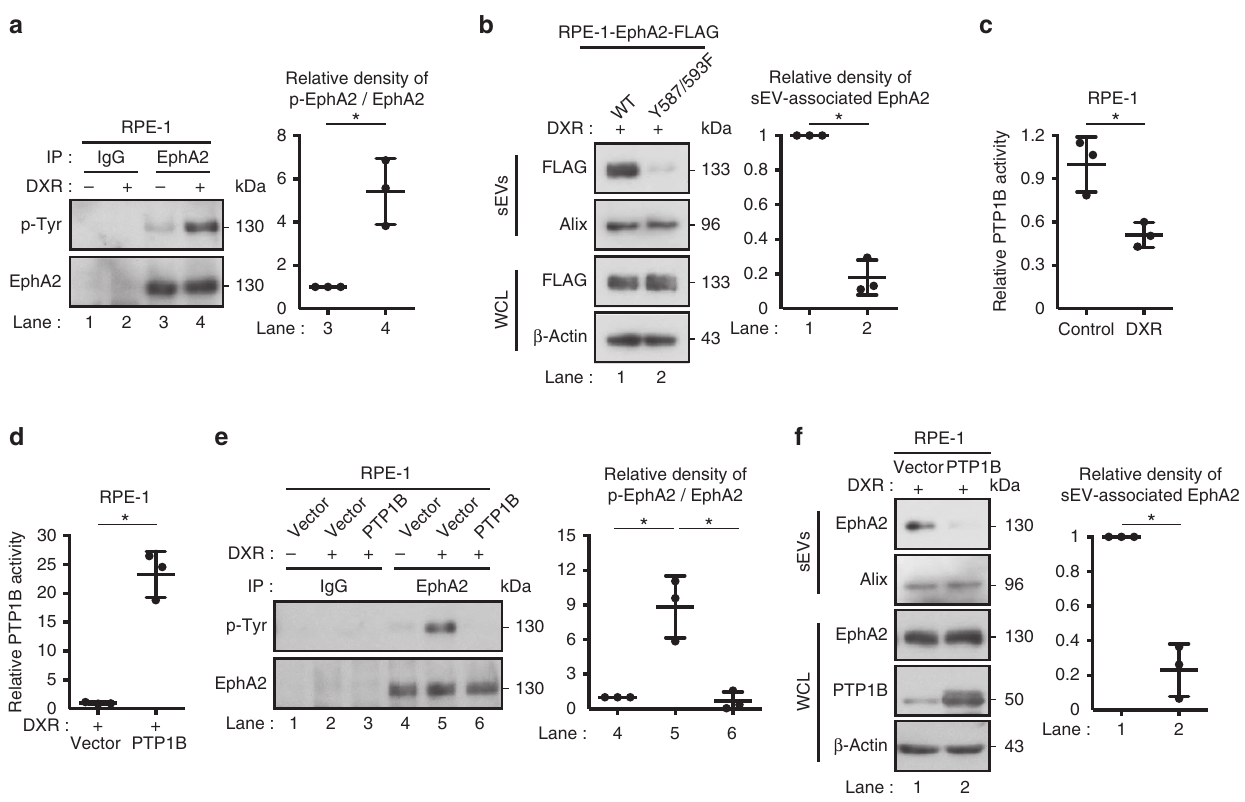
Figure 7 | EphA2 phosphorylation facilitates its sorting into sEVs in senescent cells. ( a ) EphA2 immunoprecipitates prepared from control and DXR-induced senescent RPE-1 cells were immunoblotted with anti-phosphotyrosine and anti-EphA2 antibody. Dot plot represents the relative density of phospho-EphA2/EphA2 analysed by ImageJ. ( b ) Immunoblotting of indicated proteins in the sEV fraction and WCL of DXR-induced senescent RPE-1 cells expressing wild-type or phospho-resistant EphA2 tagged with FLAG. Dot plot represents the relative density of sEV-associated EphA2 analysed by ImageJ. ( c ) Relative PTP1B activity in control and DXR-induced senescent RPE-1 cells. ( d ) Relative PTP1B activity in DXR-induced senescent RPE-1 cells expressing empty vector or ectopic PTP1B. ( e ) Immunoprecipitates prepared from control and DXR-induced senescent RPE-1 cells expressing empty vector or ectopic PTP1B were immunoblotted with anti-phosphotyrosine and anti-EphA2 antibody. Dot plot represents the relative density of phospho-EphA2/EphA2 analysed by ImageJ. ( f ) Immunoblotting of indicated proteins in the sEV fraction and WCL of DXR-induced senescent RPE-1 cells expressing empty vector or ectopic PTP1B. Dot plot represents the relative density of sEV-associated EphA2 analysed by ImageJ. Replicates are biological replicates ( n ¼ 3). Error bars indicate s.d. * P o 0.05 (two-tailed t -test for a – d , f and one-way ANOVA with the post-hoc Dunnett’s two-tailed test for e